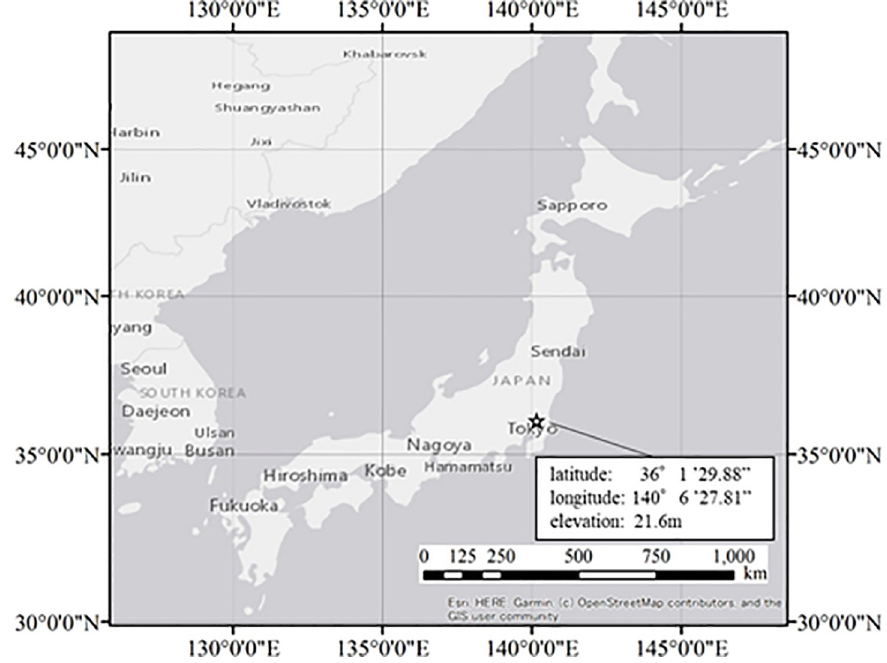
Fig 1. Location of our paddy field, the Kannondai District in Tsukuba (Japan). Location of the Kannondai District marked with a star.